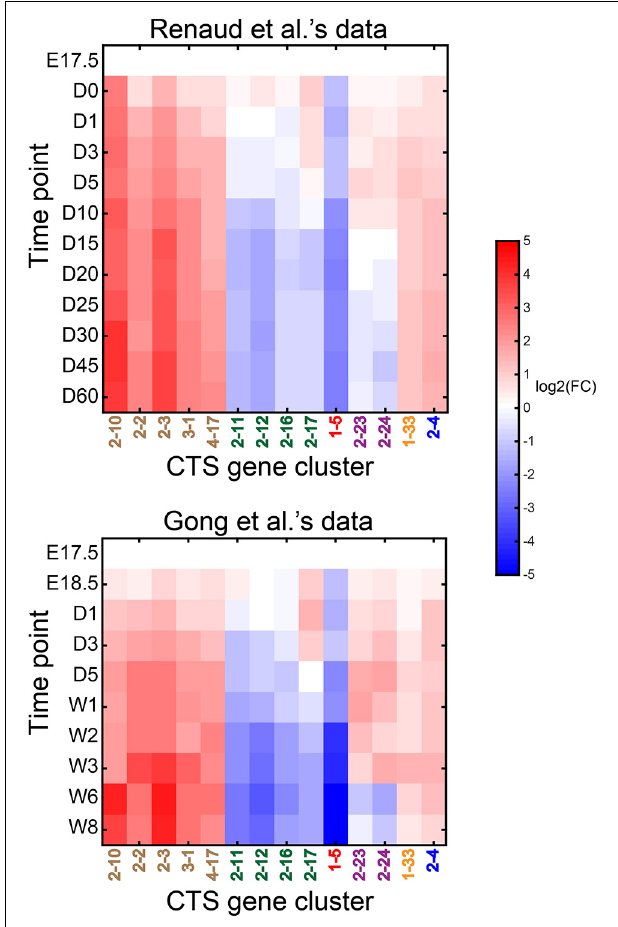
FIGURE 9 | Dynamics of significantly dysregulated CTS gene clusters during mouse liver development. The heatmap displays the expression fold change of the gene clusters during mouse liver development compared to E17.5 time point. The gene clusters in brown font are associated with hepatocytes; those in green are associated with immune cells; the one in red is associated with stem/progenitor cells; those in purple are possibly associated with vascular smooth muscle cells in the liver tissue; the one in yellow is possibly associated with hepatic stellate cells (HSCs). The representative cell type of gene cluster 1–4, in blue, is not